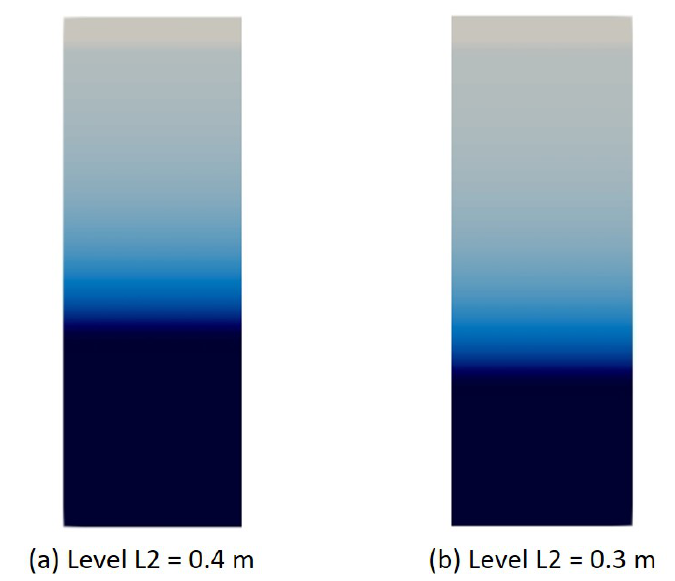
Figure 17. Comparison of the evaporation rate for different water table